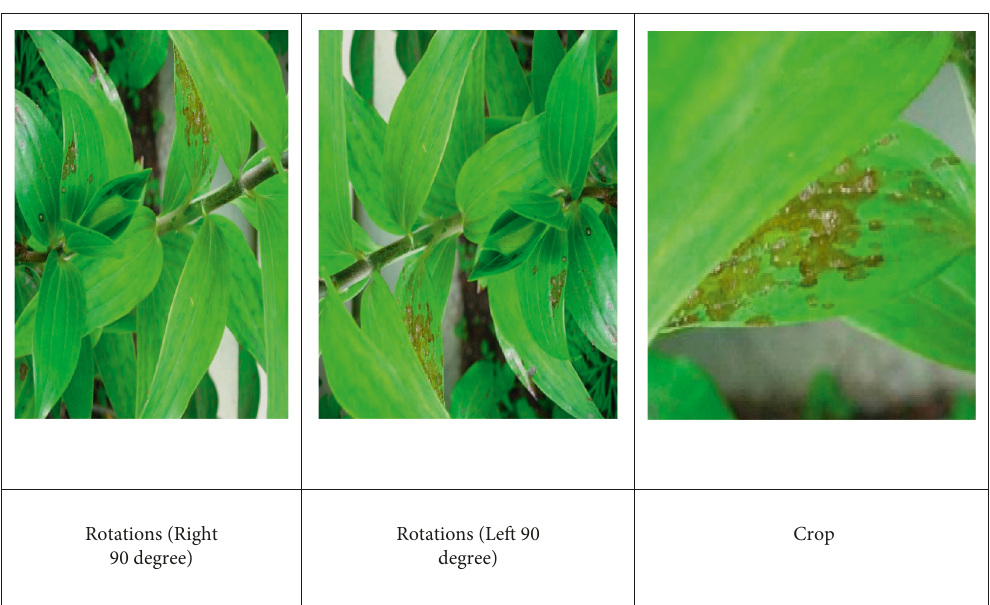
Figure 2: Sample images after augmented the original